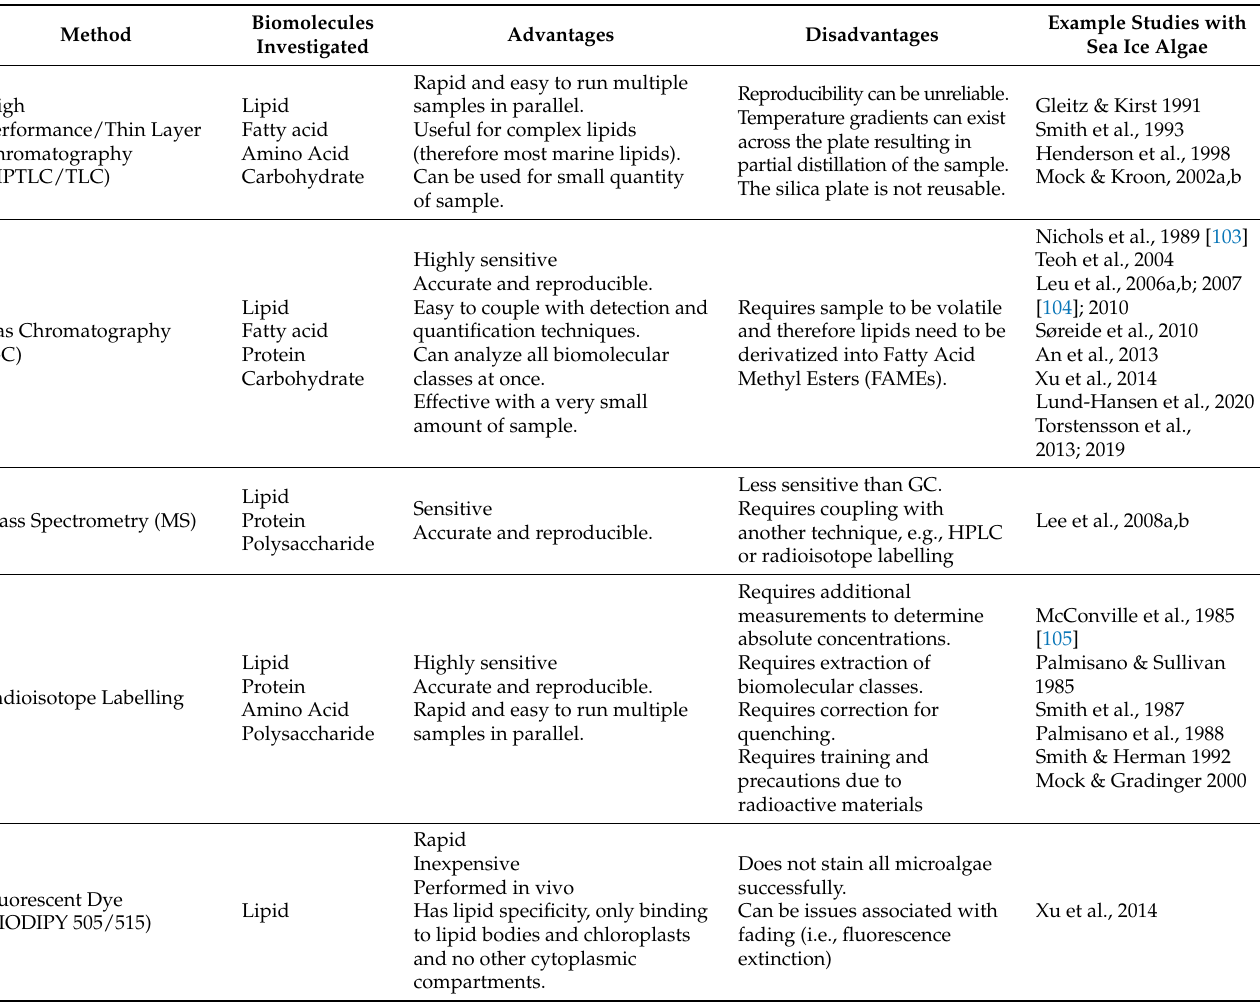
Table 2. Summary of the various analytical techniques that have been used to measure biomolecules (proteins and amino acids, lipids, and fatty acids, carbohydrates, and polysaccharides) in sea ice microalgae, their advantages, and